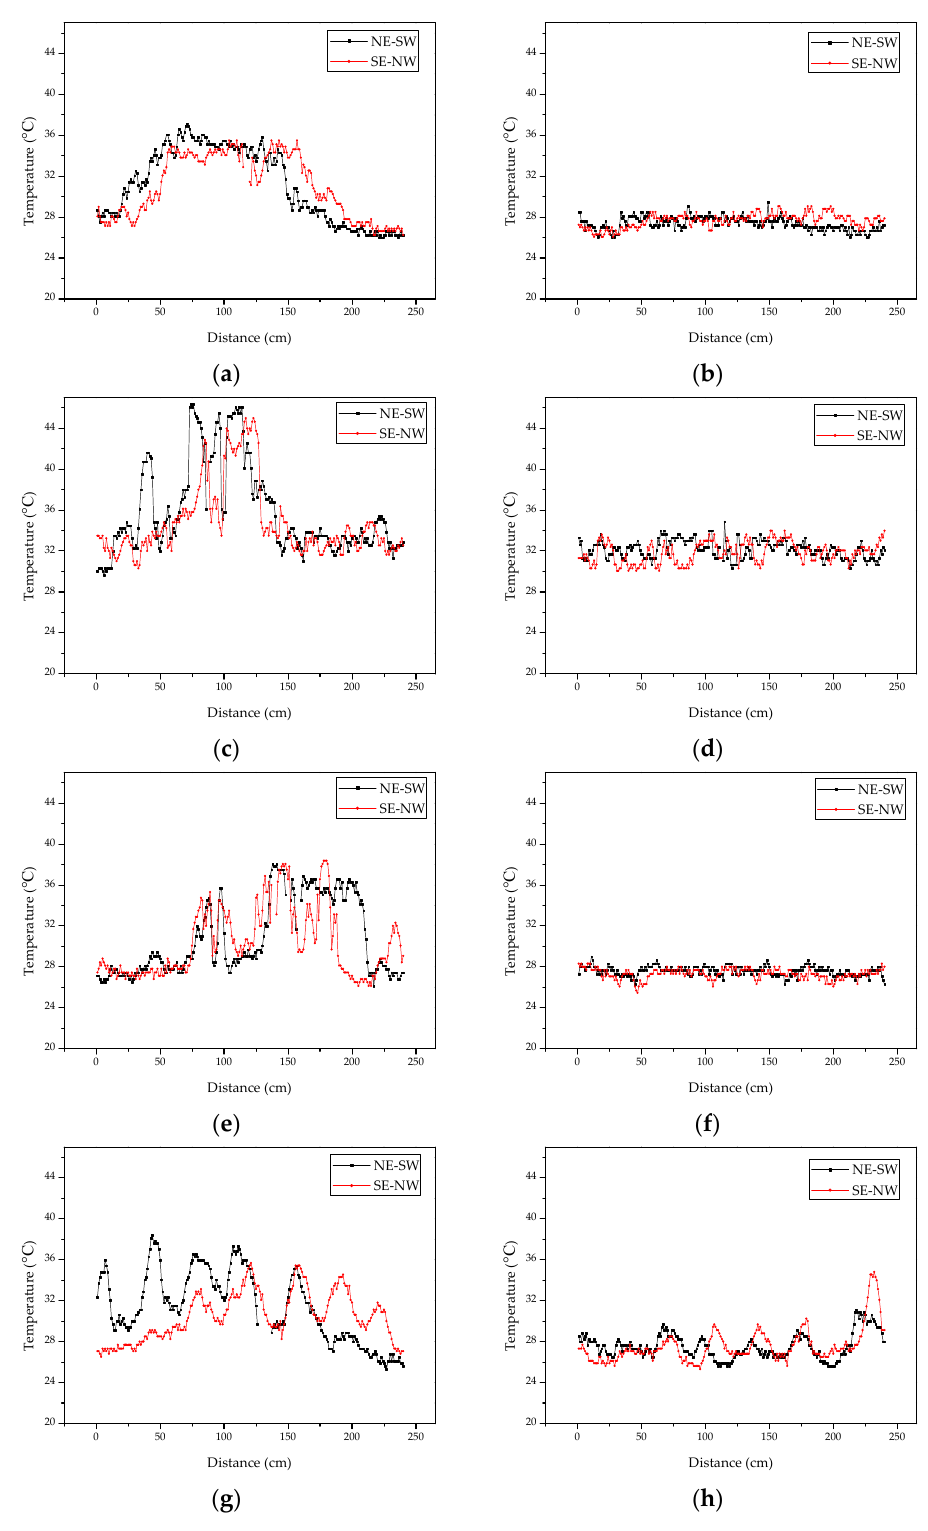
Figure 6. Temperature profiles of experimental groups: ( a ) grass; ( c ) soybean; ( e ) corn and ( g ) wheat. Temperature profiles of control groups: ( b ) grass; ( d ) soybean; ( f ) corn and ( h ) wheat.